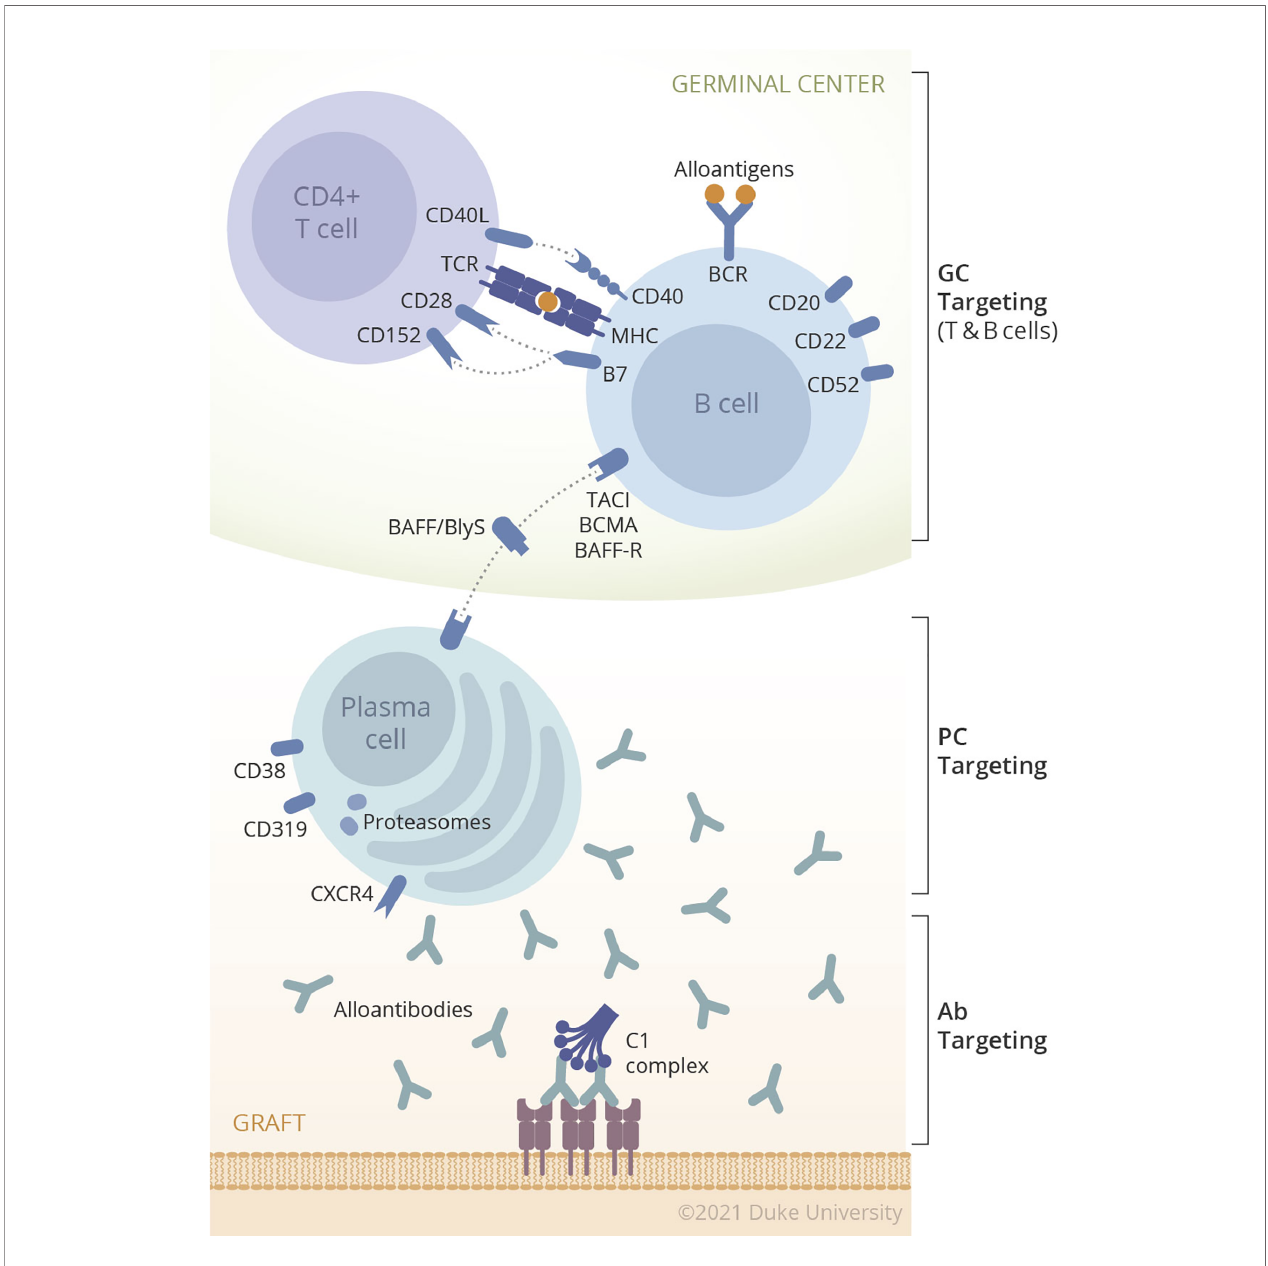
FIGURE 1 | Multiple components of humoral immunity in organ